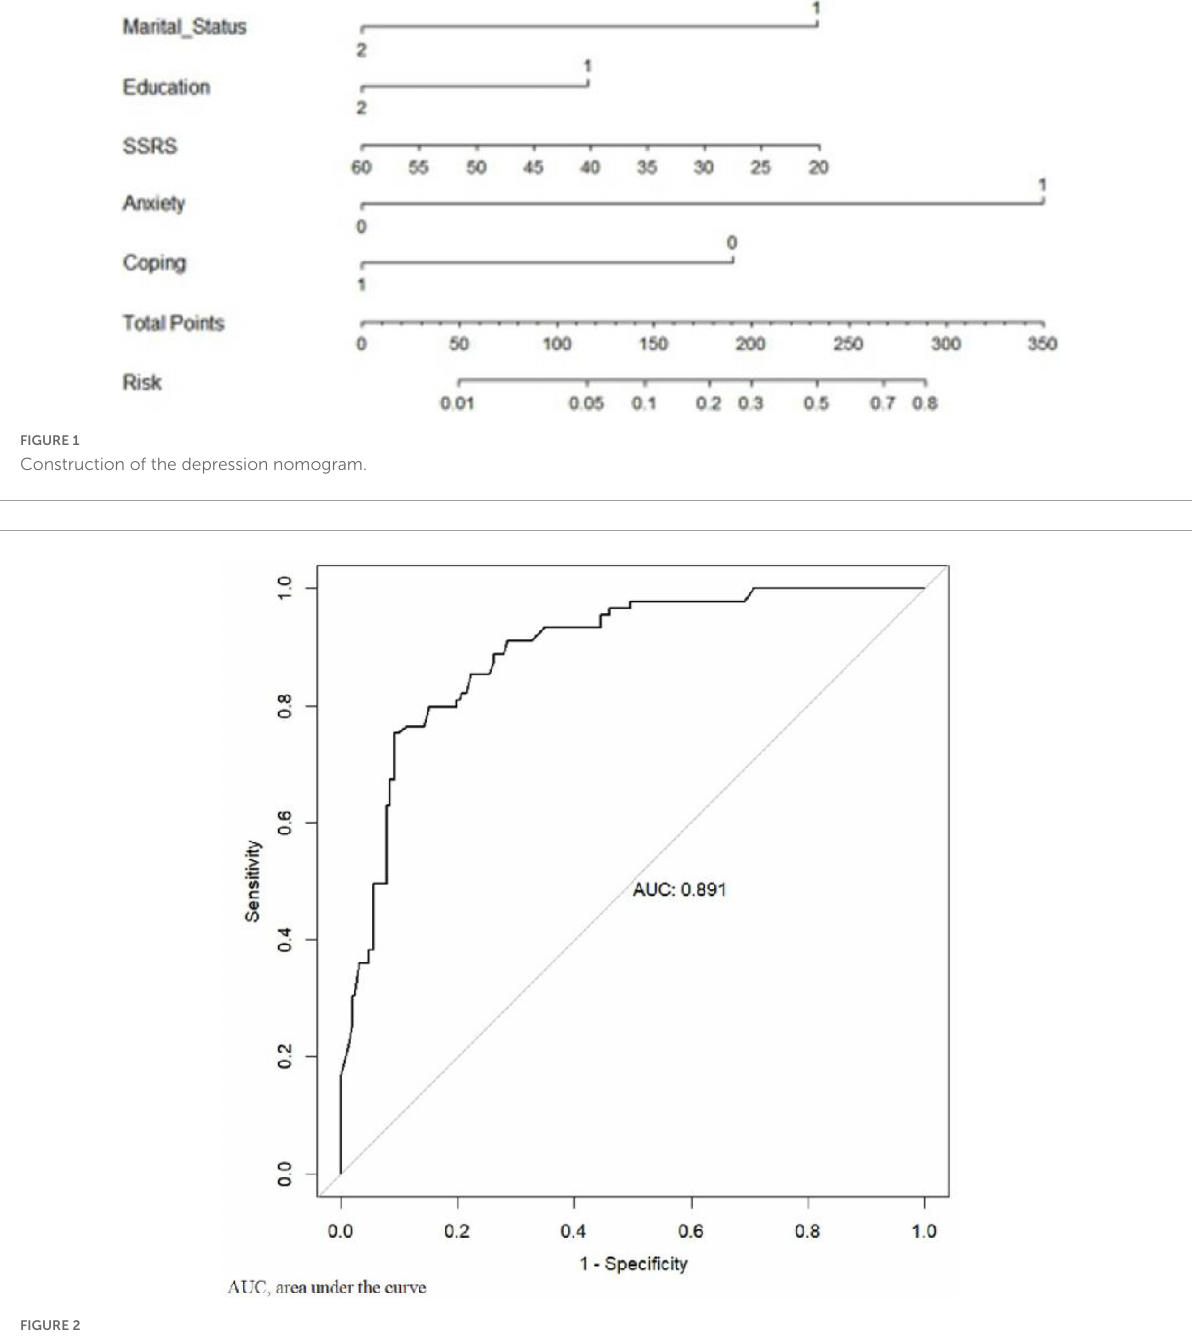
FIGURE2 Receiver operating characteristic analyses for prediction of